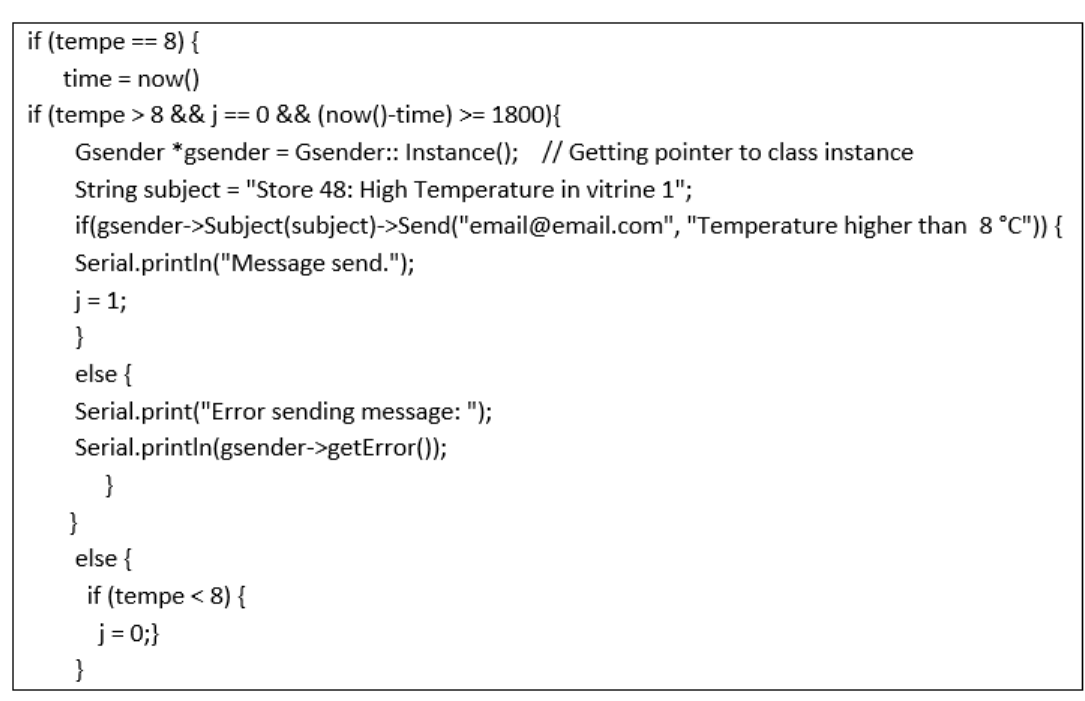
Figure 9. Alarm generation code.